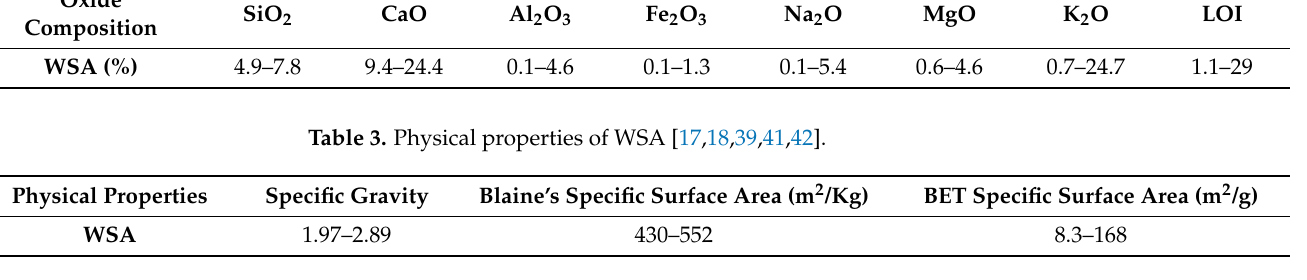
Table 4. Natural fiber chemical and morphological characteristics of WS